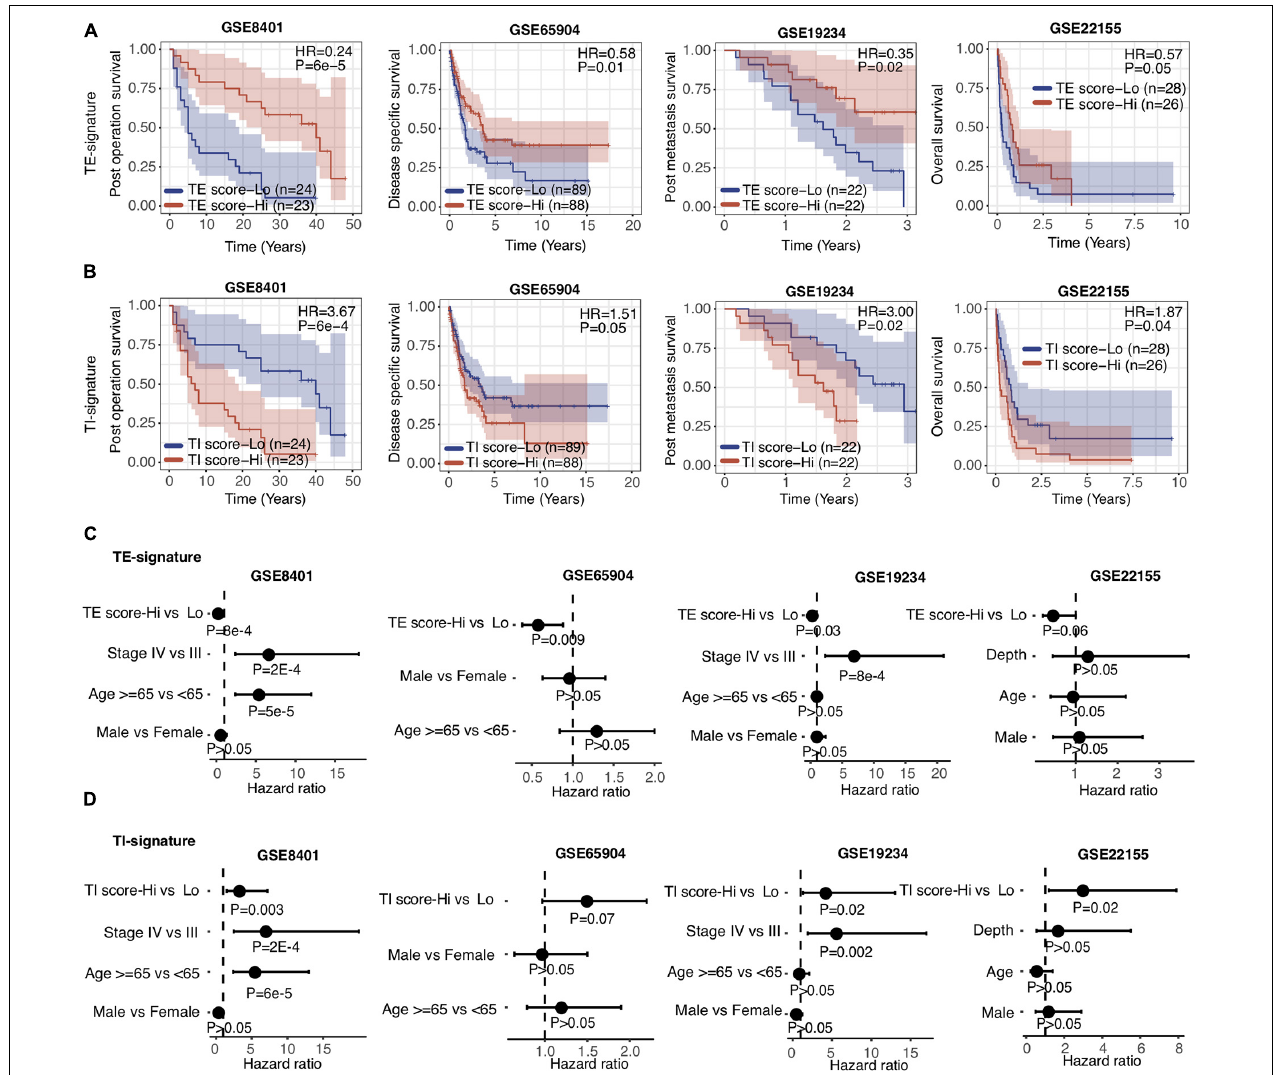
FIGURE 3 | TE signature and TI signature are prognostic in metastatic melanoma. (A,B) Kaplan–Meier plots depicting the survival distribution for patients with high (red) and low (blue) TE-signature or TI-signature scores. In Kaplan–Meier plots, p -values were calculated using the log-rank test and vertical hash marks indicate censored data. (C,D) Forest plot showing hazard ratios and p -values of TE-signature score (C) or TI-signature score (D) and several clinical variables estimated by a multivariate Cox regression model. In all forest plots, HR was presented as the 95% confidence interval, the dotted lines indicate the null association, and the Wald’s test was used to determine statistical